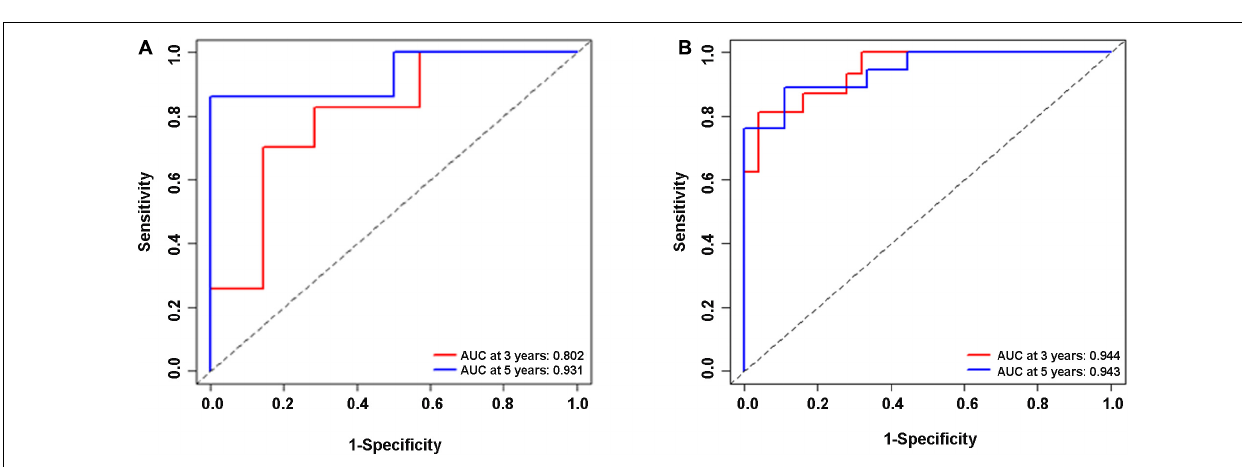
FIGURE 6 | ROC analysis of the nine-gene risk model in the validation cohort (A) and the entire sample cohort (B)